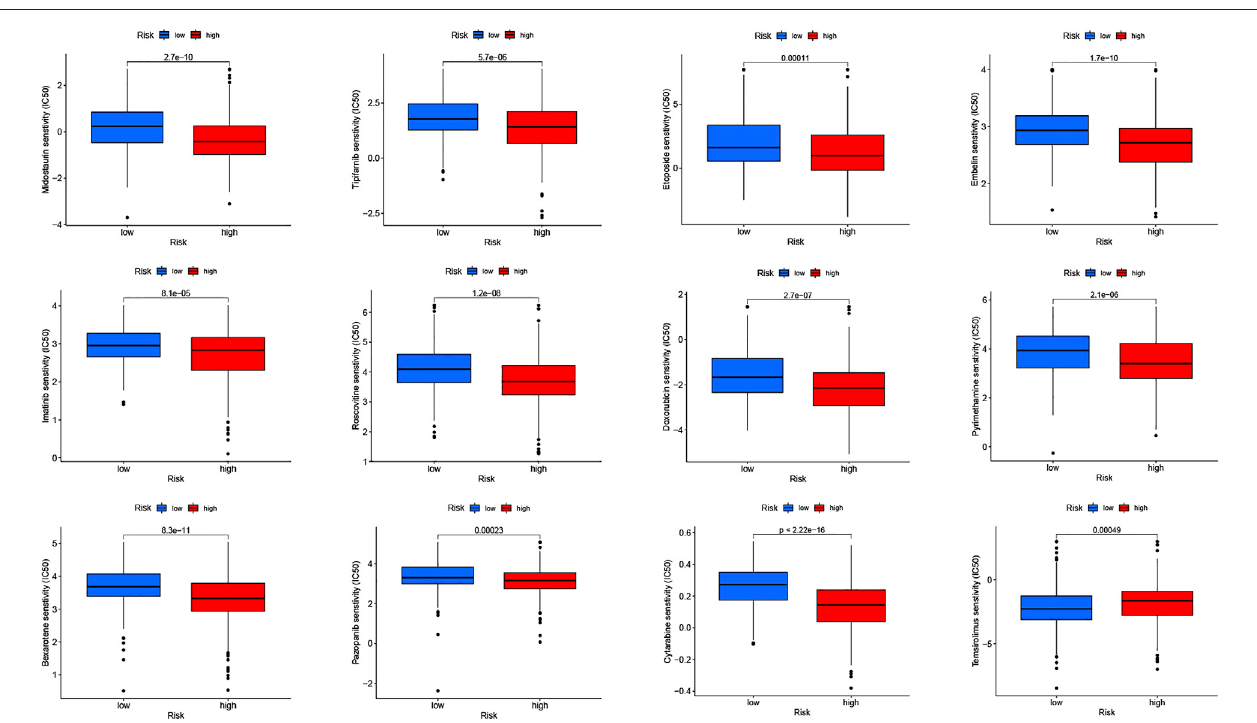
FIGURE 8 | Drug sensitivity (IC50) correlated with high- and low-risk patients in head and neck squamous cell carcinoma.